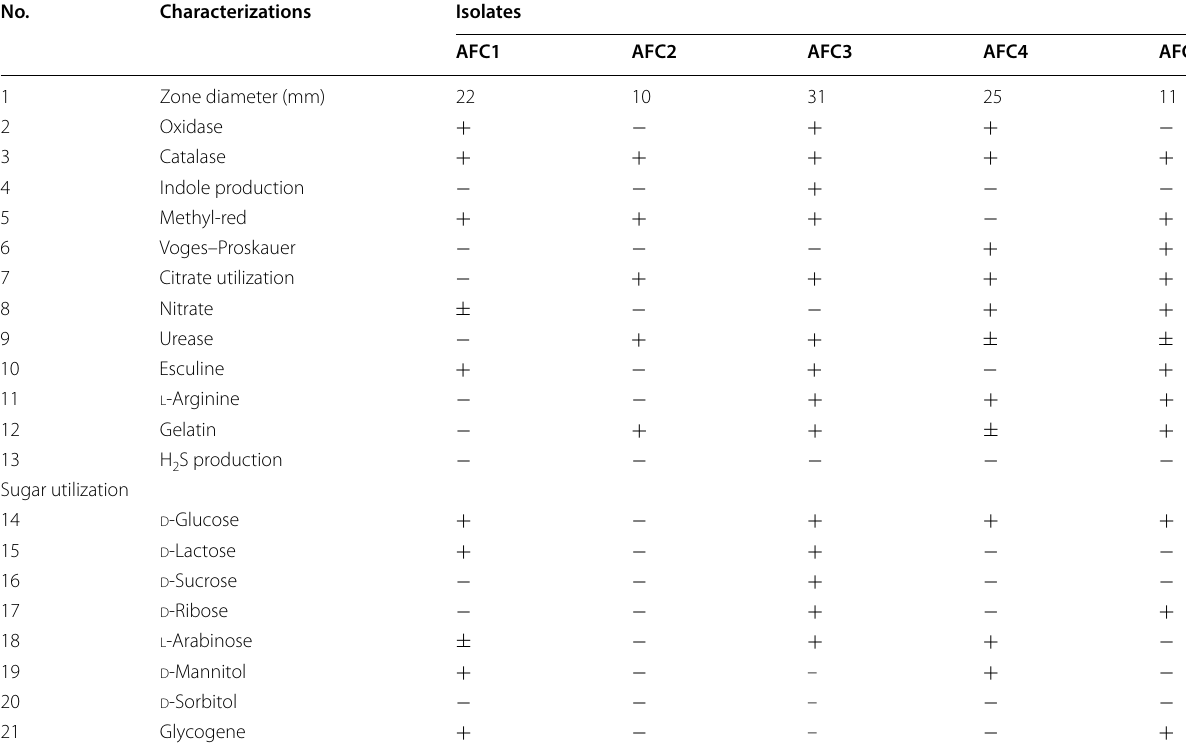
Table 4 Biochemical characterizations of isolated bacteria from termite gut